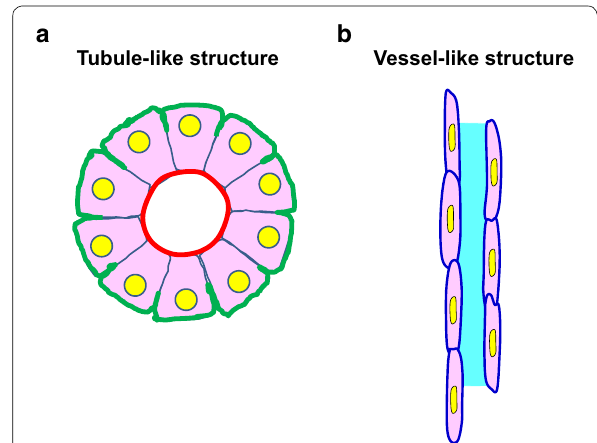
Fig. 1 Illustration of the differences between a tumor cell‑derived tubule‑like structure and a vessel‑like structure. a A cross section of a tubule‑like structure showing multiple cuboidal cells forming a tubular structure. This kind of structure might be able to express different proteins in the apical membrane ( red ) and basolateral mem‑ brane ( green ). Polarization of nuclei ( yellow ) might be observed. b A longitudinal section of a vessel‑like structure showing elongated cells with alternative staggered distribution of the nuclei, resulting in only one nucleus or no nucleus in any cross section. Notably, the rod-like structure of the nuclei indicates the trans‑differentiation tendency from cancer cells to the cells forming blood vessel. Moreover, the ves‑ sel lumen ( light blue ) might be absent depending on different stages of